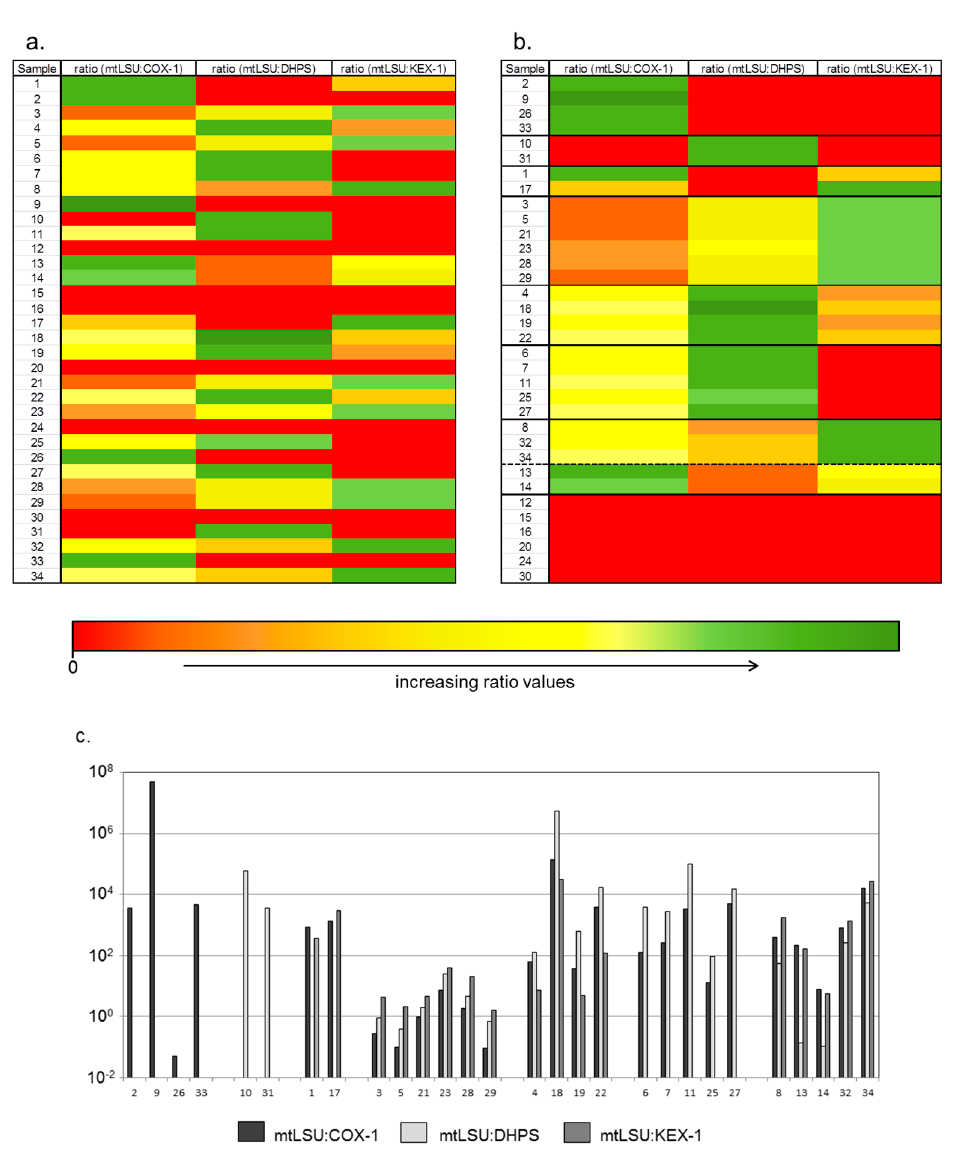
Figure 1. Copy number ratios of COX1 , KEX1 and DHPS vs. the diagnostic relevant mtLSU gene in 29 BALF samples with high titer of mtLSU gene copies ( ≥ 1 × 10 7 mtLSU copies/mL). ( a ) Unsorted heatmap; ( b ) sorted heatmap; ( c ) According to their ratio pattern the samples were divided into seven clusters. In the clusters A and B only COX1 or DHPS were detected besides mtLSU , whereas in the clusters C and F DHPS or KEX1 are missing. In samples of the clusters D, E and G all target genes were detected, but each cluster displays a different ratio pattern.